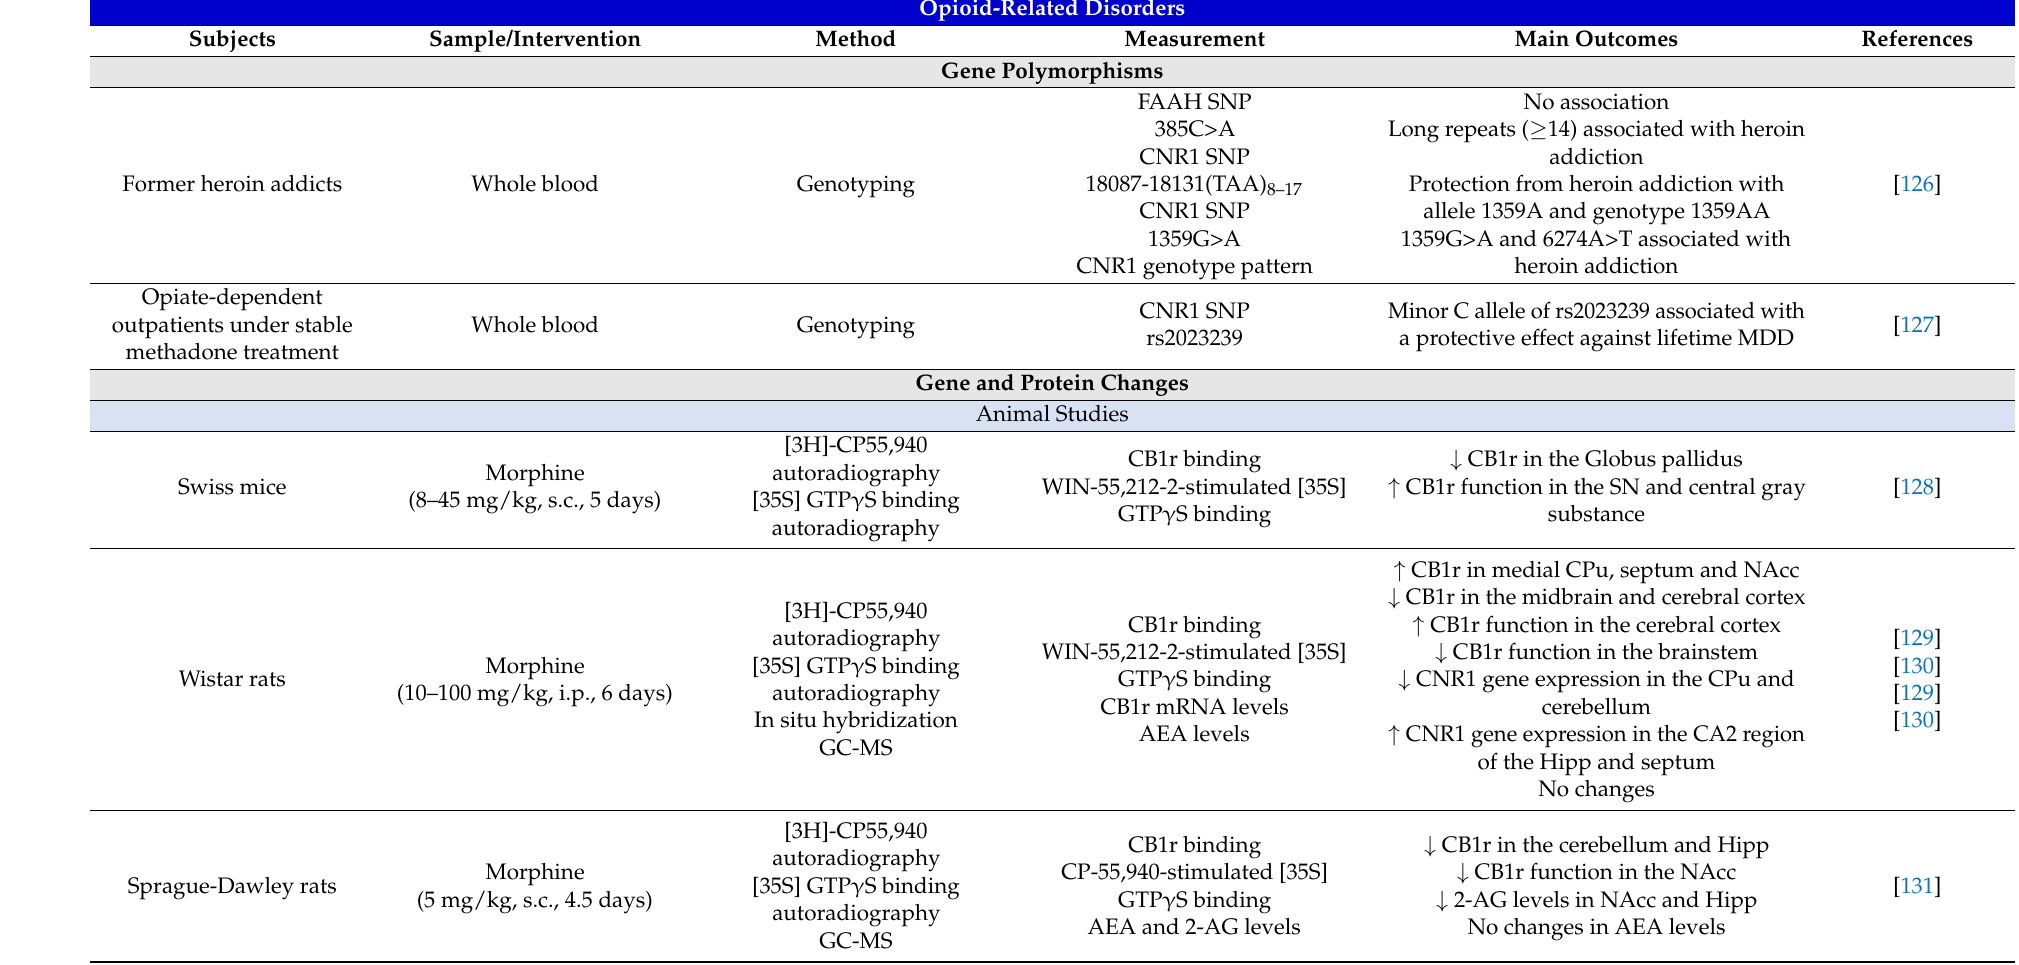
Table 3. Main findings from human and animal studies aimed to identify alterations of ECS components in opioid-related